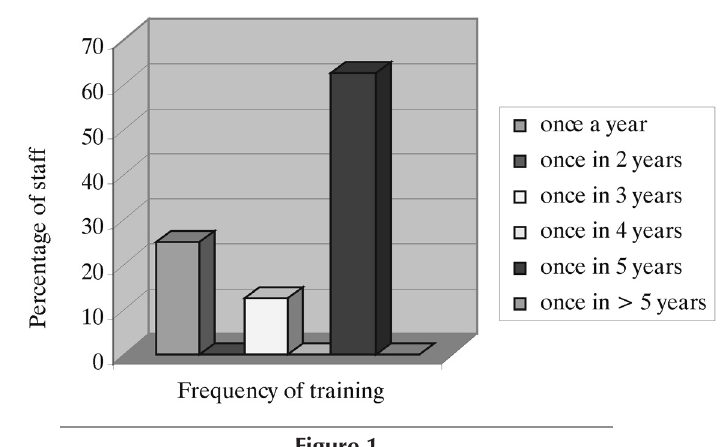
Figure 1 Training of R&D